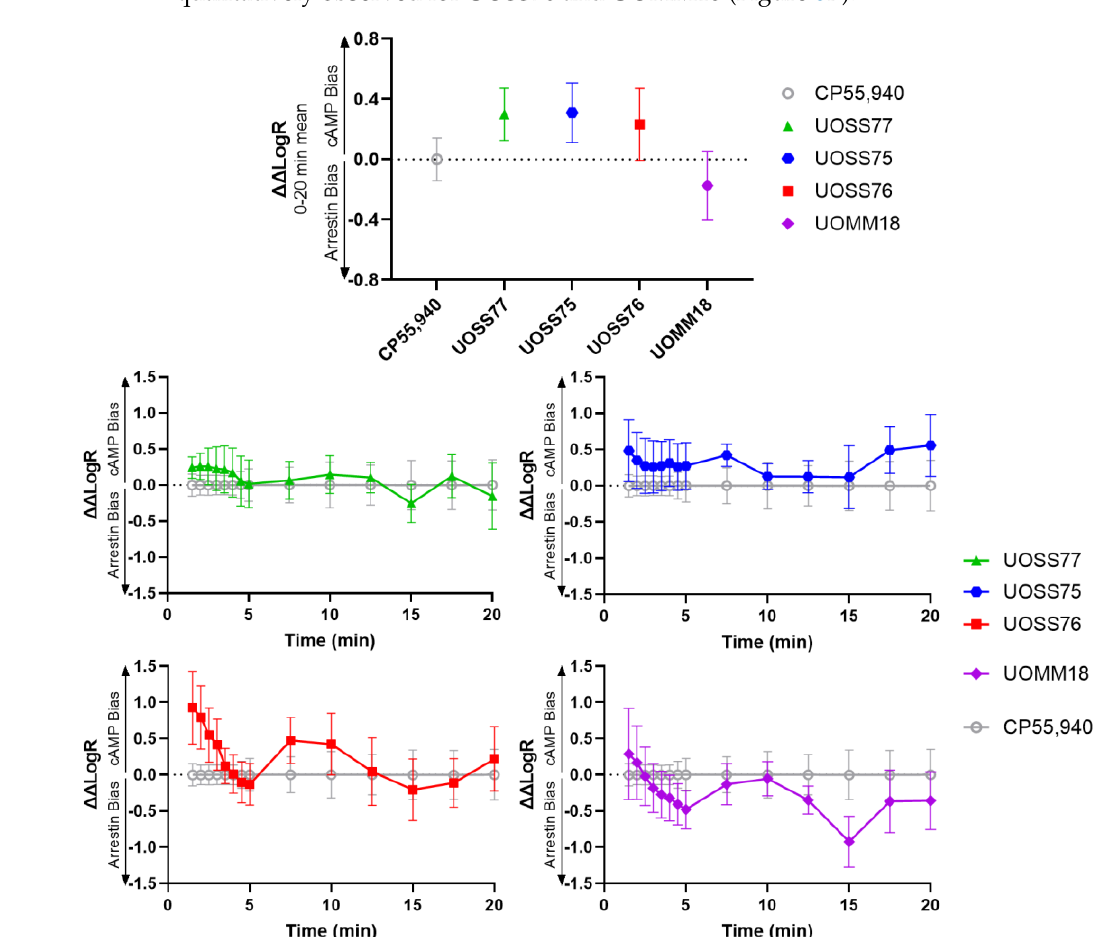
Figure 6. Signalling bias relative to CP55,940. Bias quantified as ΔΔLogR for cAMP signalling (positive; “cAMP Bias”) versus β-arrestin-2 translocation (negative; “Arrestin Bias”). ( A ) Bias for mean responses over a 20 min stimulation. ( B ) Bias at different time points throughout a 20 min stimulation. Data represents mean ± SEM from three to four independent experiments for each pathway.